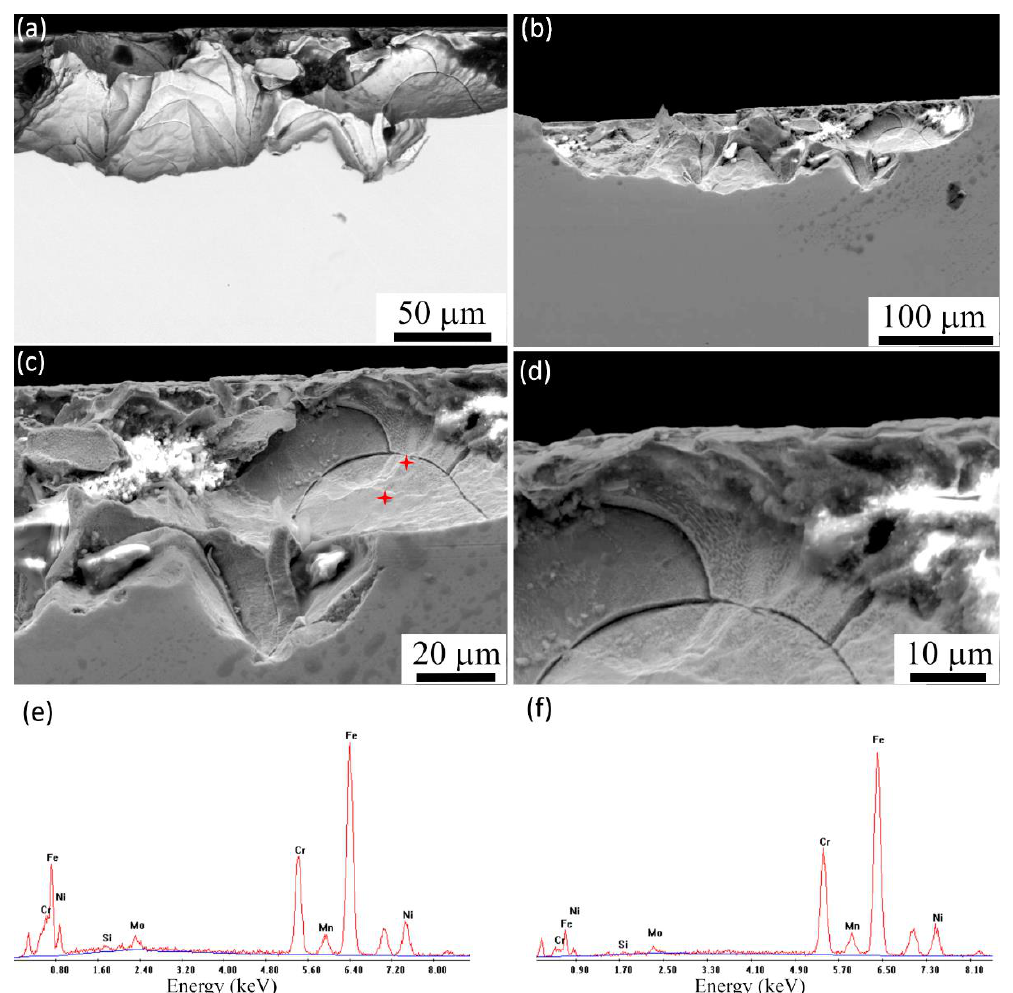
Figure 13. SEM images of specimens with 460 MPa RS magnitude after galvanostatic test condition with the immersion time of 500 s; ( a ) backscatter electron mode image with clear evidence of SCC cracks along melt pool direction, transgranular crack propagation, tearing due to high RS magnitude, and SCC branching in both melt pool direction and transgranular form. ( b – d ) Secondary electron mode images with different magnifications showing SCC crack branching along the melt pool boundaries ( e , f ) EDX–SEM analysis of the point shown on image ( c ) with red stars, showing slight segregation of Molybdenum the near melt pool. Table 4. EDX–SEM compositional analysis (wt.%) of the regions shown in Figure 13c,e,f